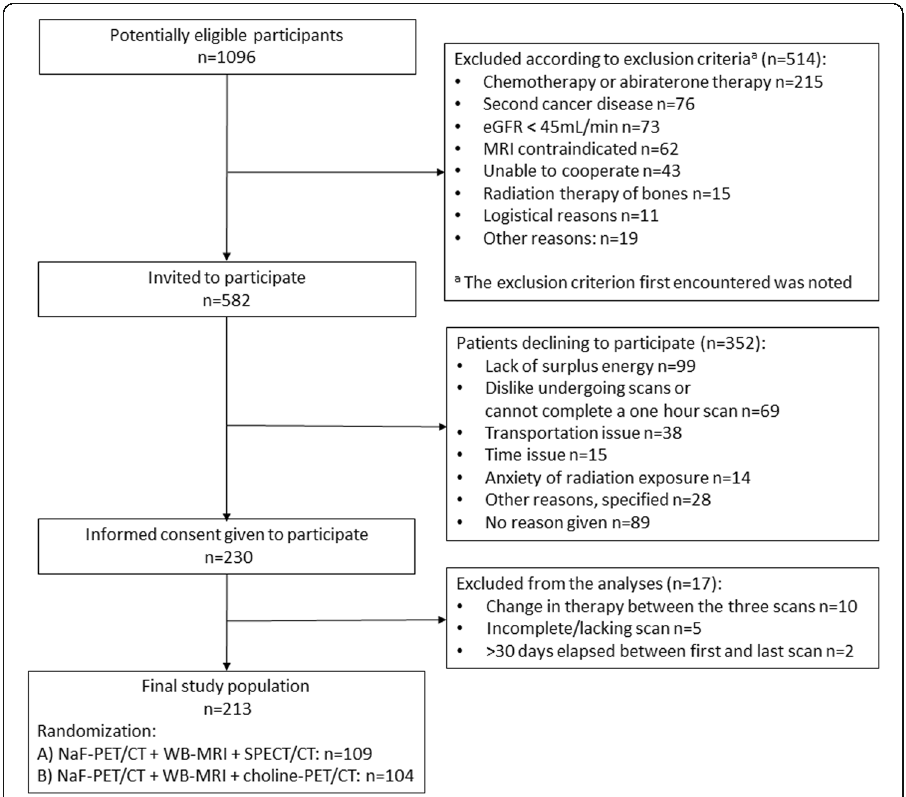
Fig. 1 Flow diagram illustrating the inclusion of study